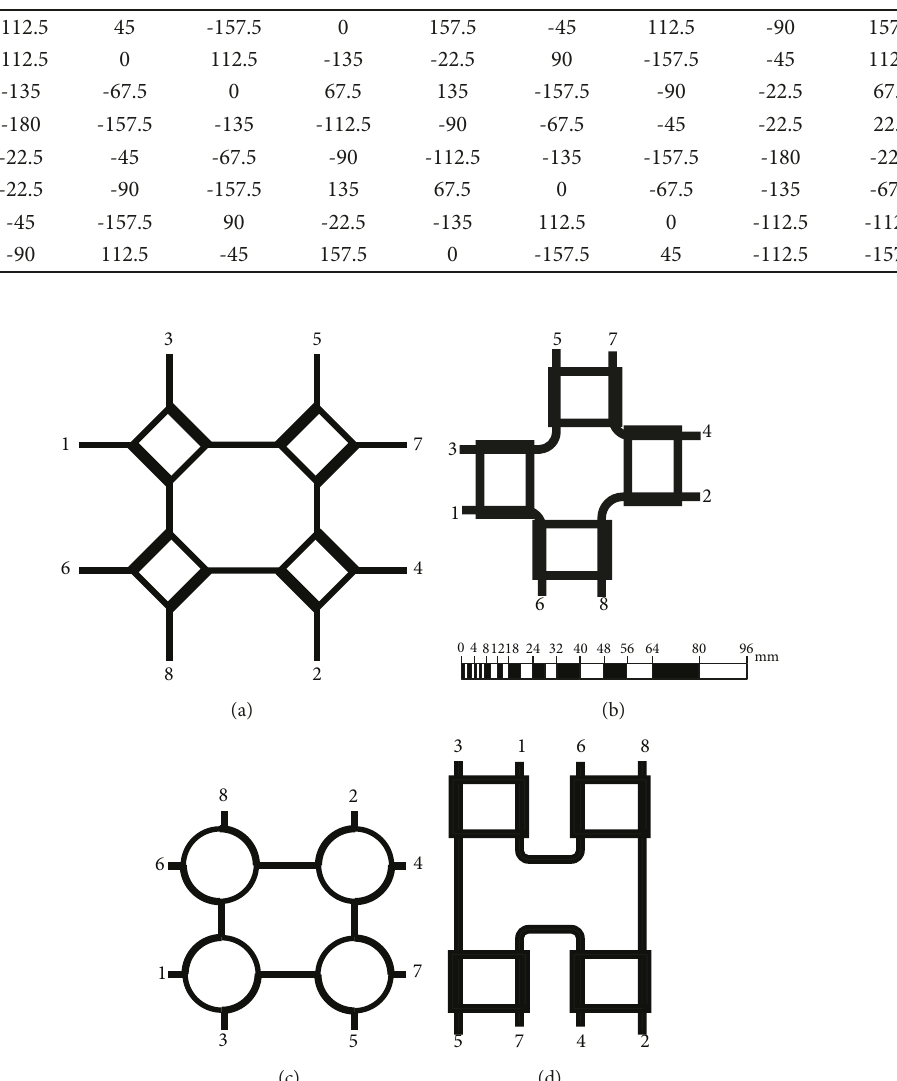
Figure 2: Four di ff erent layouts for the designed 4 × 4